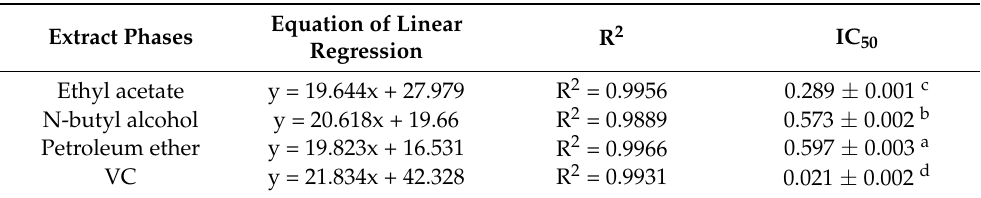
Table 10. Hydroxyl radical scavenging activity of Pleioblastus amarus (Keng) shell with different extraction phases on hydroxyl radical. Equation of Linear Extract Phases R 2 IC 50 Regression Ethyl acetate y = 19.644x + 27.979 R 2 = 0.9956 0.289 ± 0.001 c N-butyl alcohol y = 20.618x + 19.66 R 2 = 0.9889 Petroleum ether y = 19.823x +